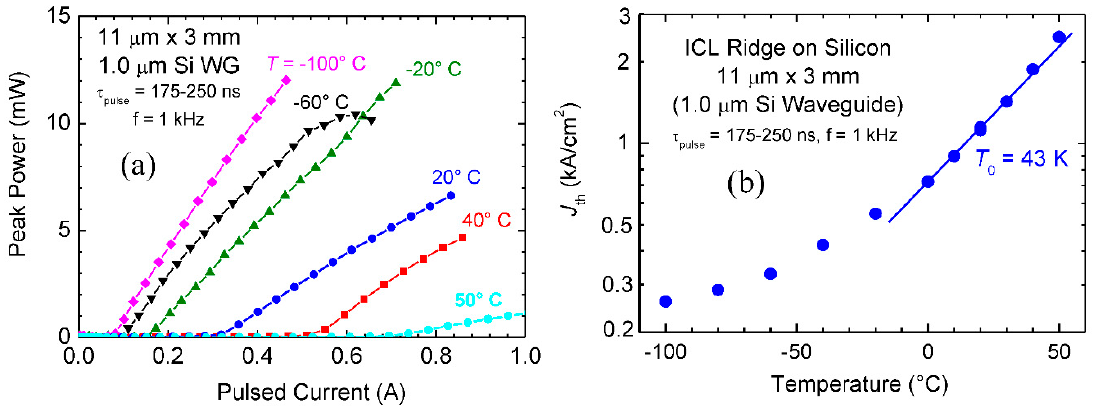
Figure 23. ( a ) Pulsed L-I characteristics of an ICL integrated on silicon from one facet polished to remove the taper, at temperatures ranging from − 100 °C to 50 °C. ( b ) Threshold current density vs. temperature from the same data. Reproduced from Ref. [220], with the permission of OSA Publishing.